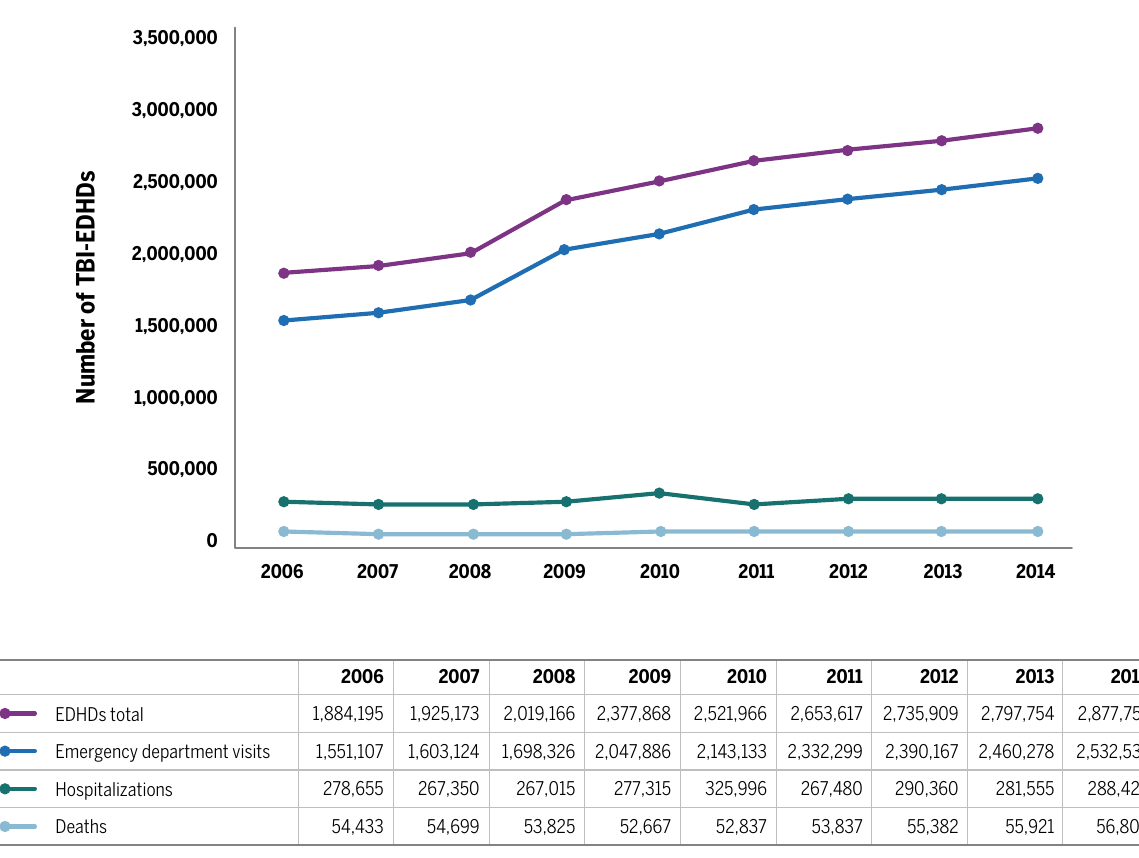
FIGURE 1: ESTIMATED NUMBER OF TRAUMATIC BRAIN INJURY-RELATED EMERGENCY DEPARTMENT VISITS, HOSPITALIZATIONS, AND DEATHS (TBI-EDHDS) BY YEAR,